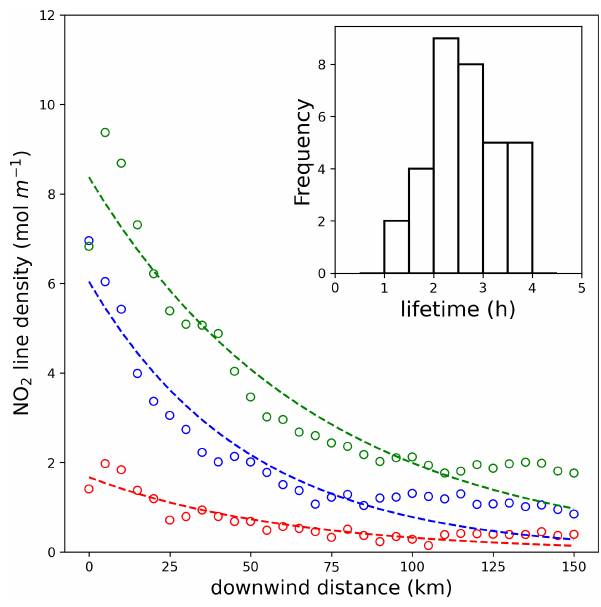
Figure 9. NO 2 line density decay curves of three example fire events (each color represents a fire event) in Area 2. The embed- ded histogram shows the frequency distribution of NO 2 lifetime es- timated from all three